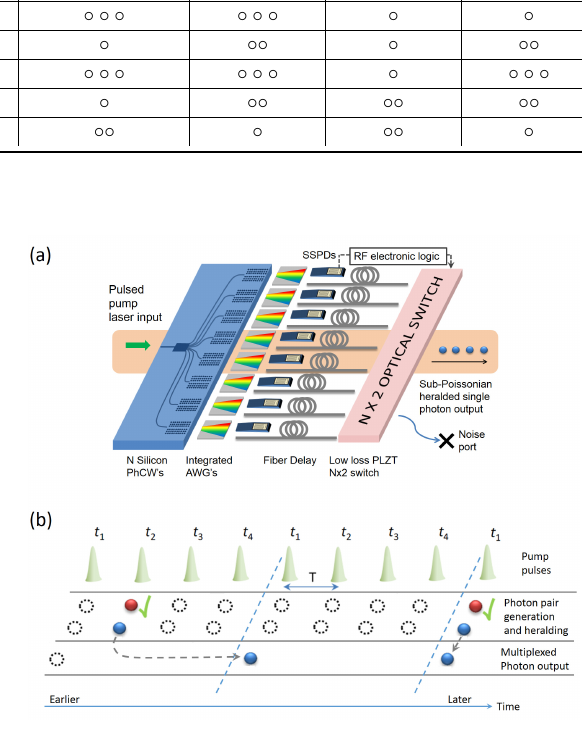
Fig. 9. Diagram for (a) integrated active spatial multiplexing [57], and (b) active temporal multiplexing